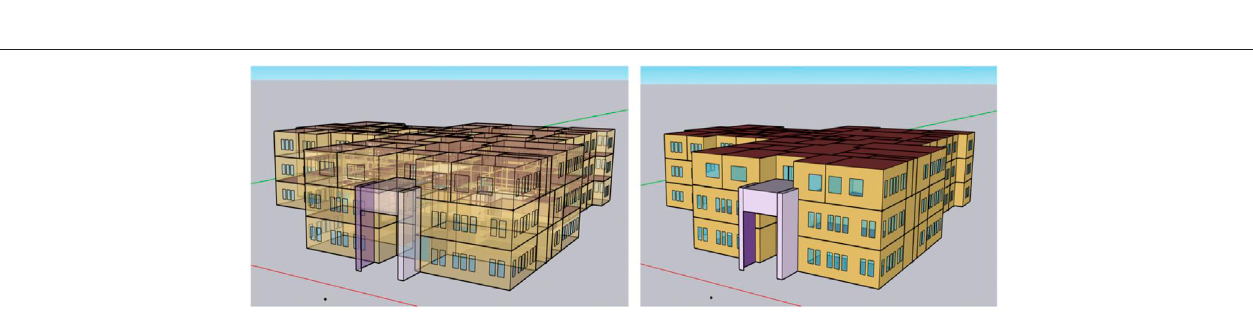
FIGURE 2 | Geometry of the of fi ce building and its x-ray